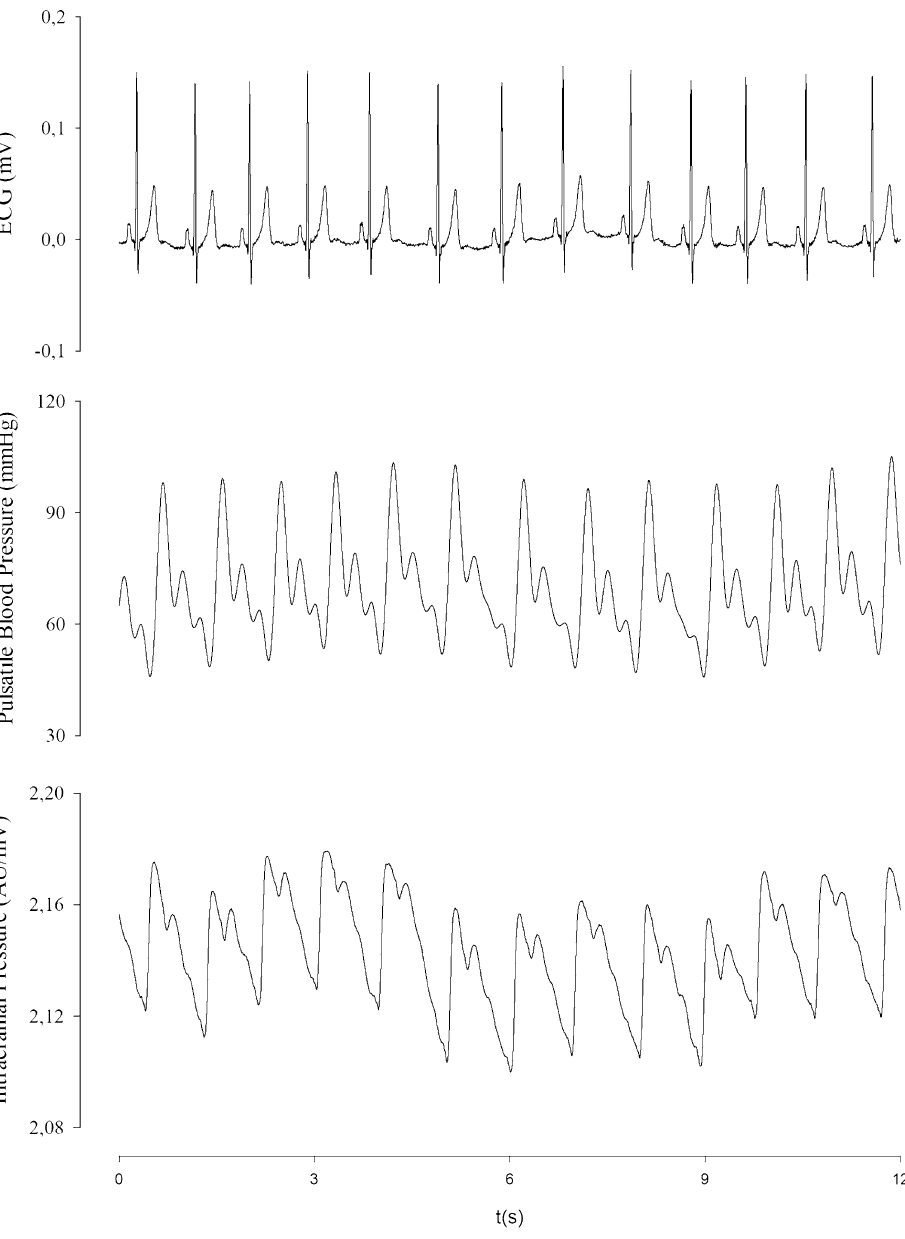
Figure 2. Illustration of the data synchronization of heart rate (mV), blood pressure (mmHg) and the ICP-NI measurement